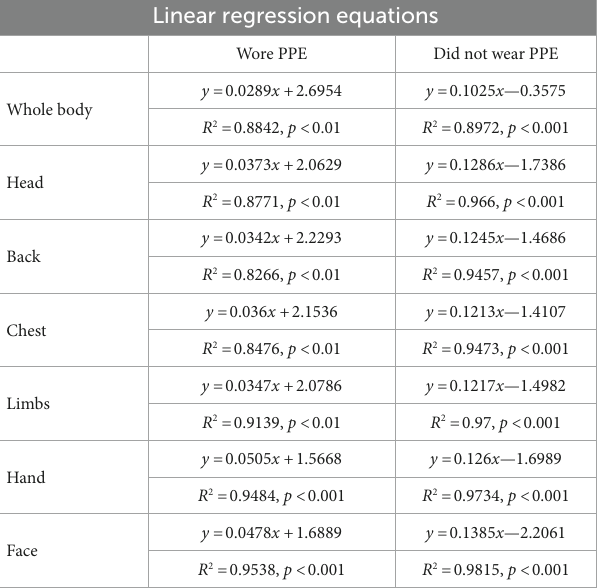
TABLE 4 Results of linear regression equations for mean thermal sensation vote (MTSV) against T a . Linear regression